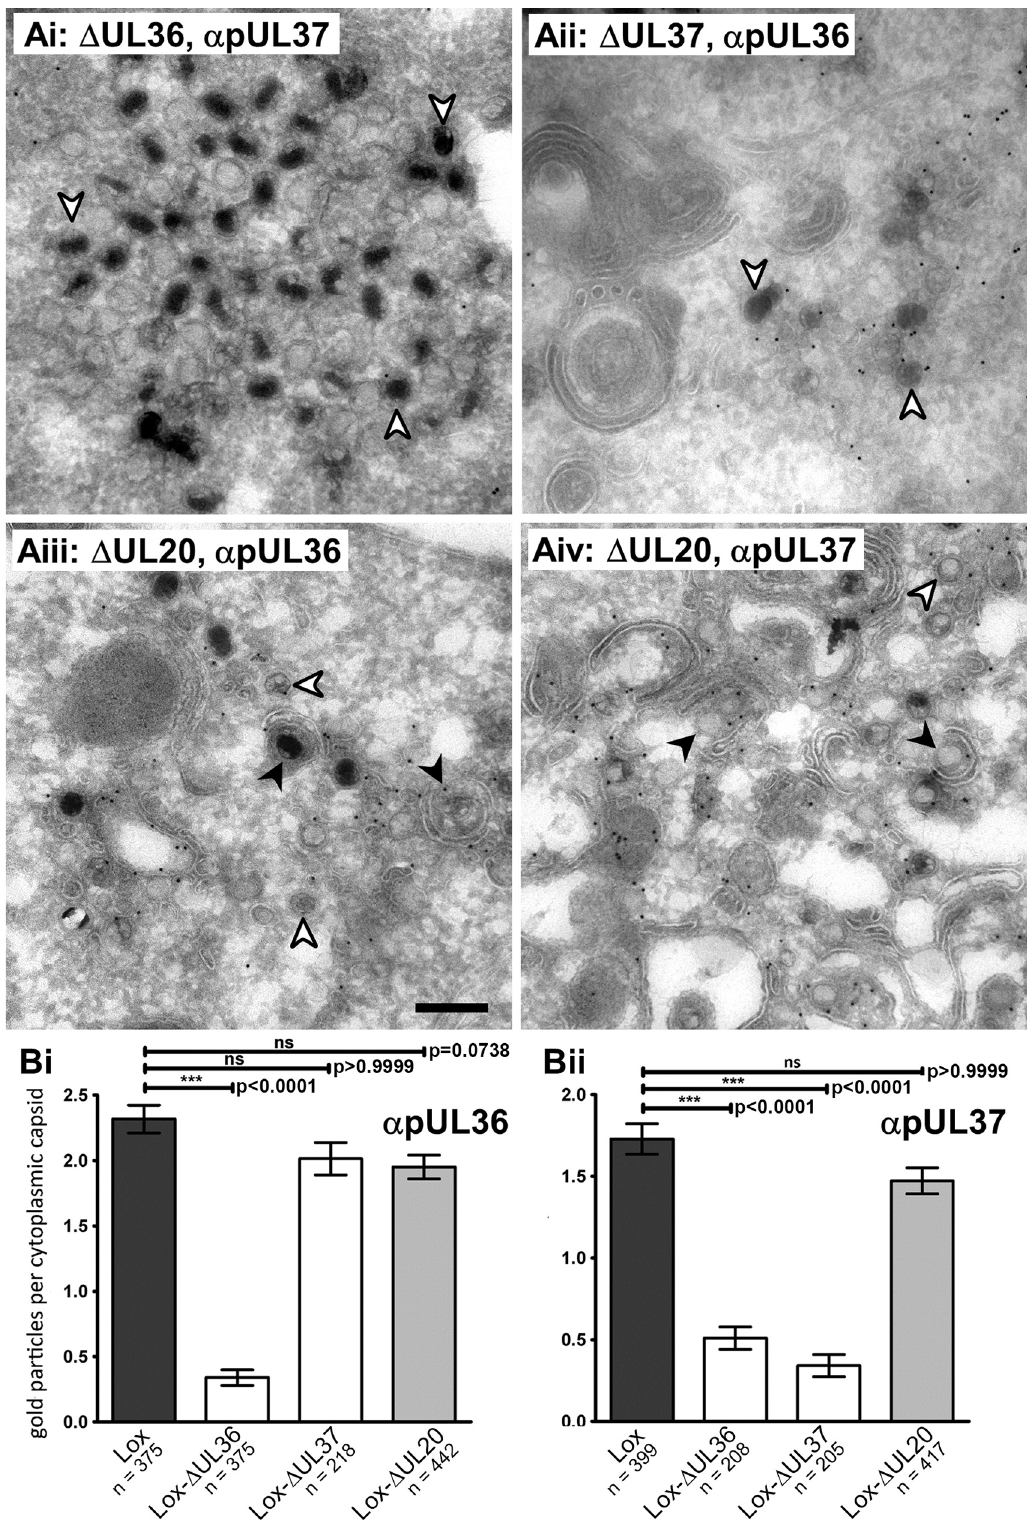
Fig 3. In the absence of pUL20, HSV1 capsids associate with pUL36 and pUL37. (A) Vero cells were infected with 1.1 x 10 7 pfu/mL (10 pfu/cell) of HSV1(17 + )Lox- Δ UL36 (i), - Δ UL37(ii) or - Δ UL20(iii and iv). At 16 hpi, the cells